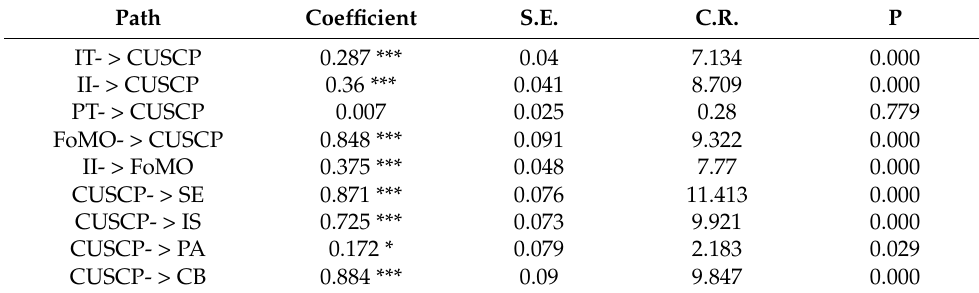
Figure 3. Basic model testing results. n = 366; *** p ≤ 0.001, ** p ≤ 0.01. Table 7. Path analysis of basic